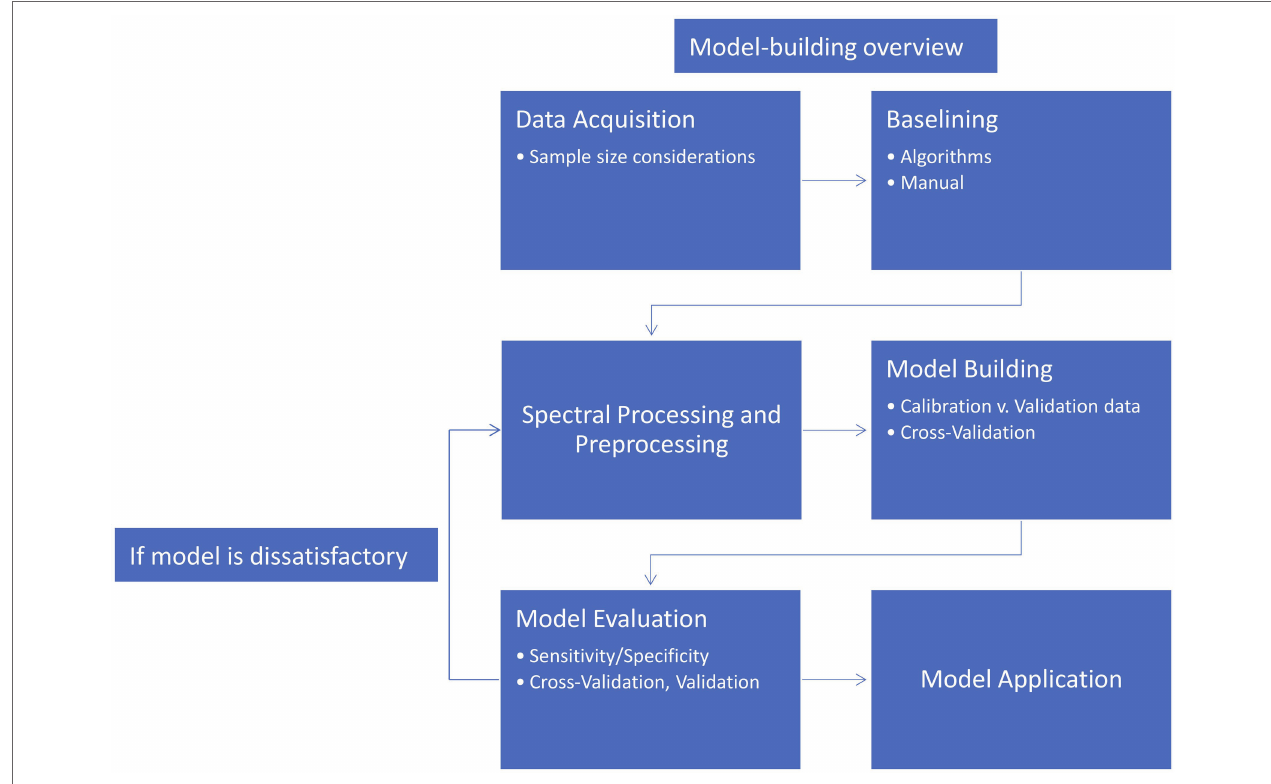
FIGURE 3 | Flowchart of model construction and